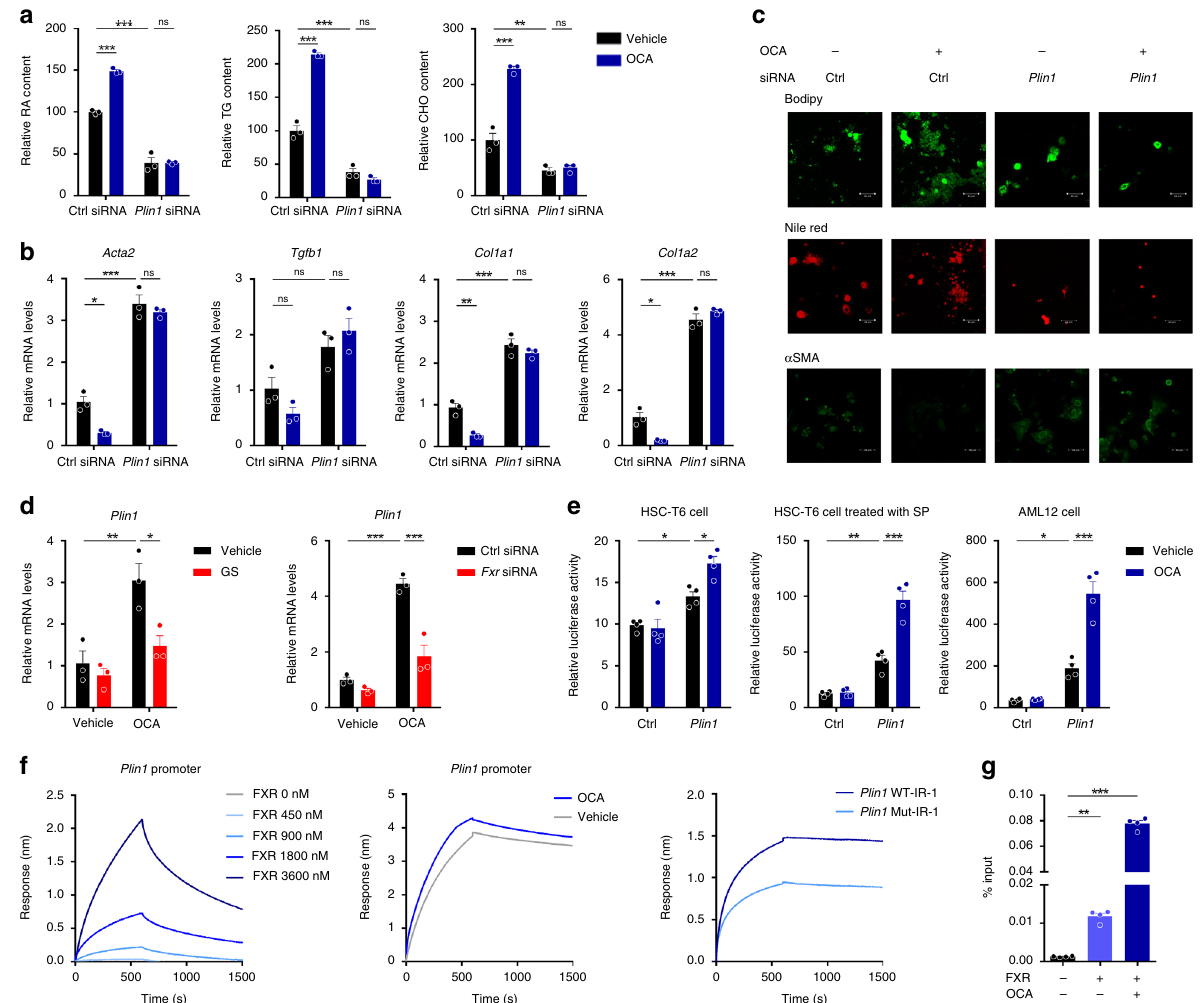
Fig. 9 OCA stabilizes LD and inhibits HSC activation via FXR-Plin1 pathway. a – c The effect of OCA in precluding LD loss and HSC activation depends on Plin1 ( n = 3 biologically independent samples). Cells transfected with ctrl or Plin1 siRNA were treated with OCA. a Lipids quantitation. b mRNA expression of pro- fi brotic genes. c Bodipy, Nile red, and α -SMA staining of cells (representative of n = 3 biologically independent samples. Scale bar, 50 μ m). d FXR antagonist and FXR knock-down abolished the upregulation of Plin1 by OCA ( n = 3 biologically independent samples). e Reporter gene analysis of the Plin1 promoter in HSC-T6 cells in the absence or presence of SP, and in AML-12 cells ( n = 4 biologically independent samples). f BLI analysis for the association between recombinant human FXR protein and Plin1 promoter. g ChIP analysis for the association between endogenous FXR and Plin1 promoter ( n = 4 biologically independent samples). Results are mean ±SEM, * P < 0.05, ** P < 0.01, *** P < 0.001, and ns, statistically not signi fi cant, as assessed